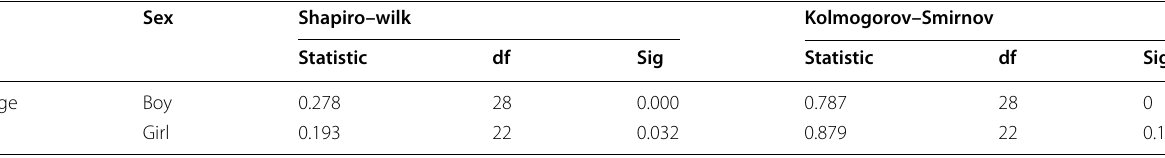
Table 1 The distribution of age variable data among gender groups